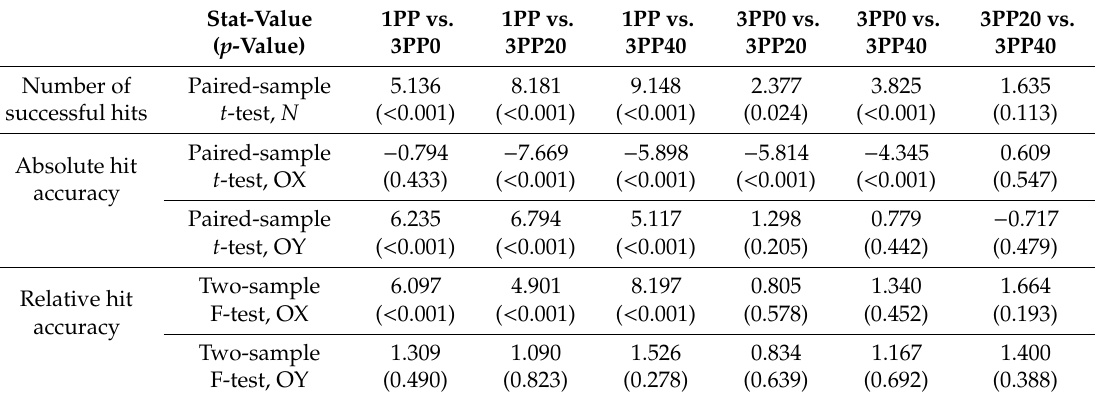
Table 2. Statistical e ff ects of di ff erences in the number of successful hits, absolute and relative accuracy of